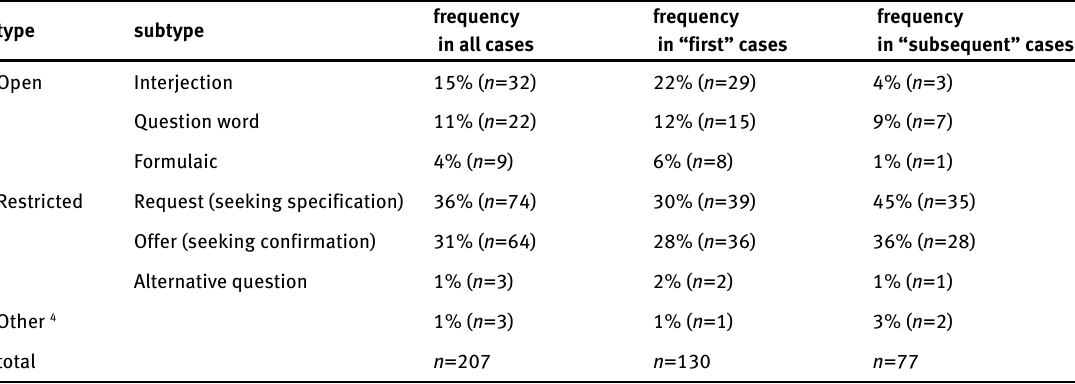
Table 3: Types of repair initiators and their frequency in the Italian